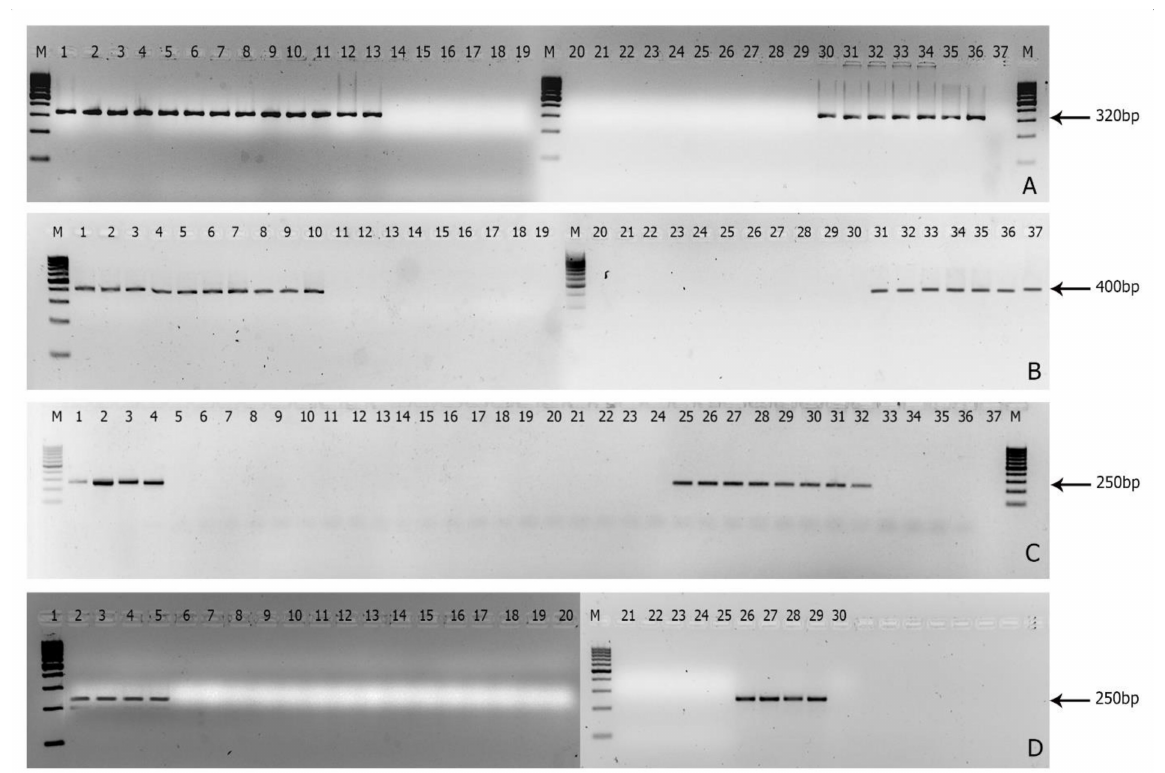
Figure 2. Development of molecular markers for the specific detection of Foc races; ( A ): amplicons of Foc R1F/ Foc R1R primer set for Foc R1; ( B ): amplicons of Foc R4F/ Foc R4R primer set for Foc R4; ( C ):